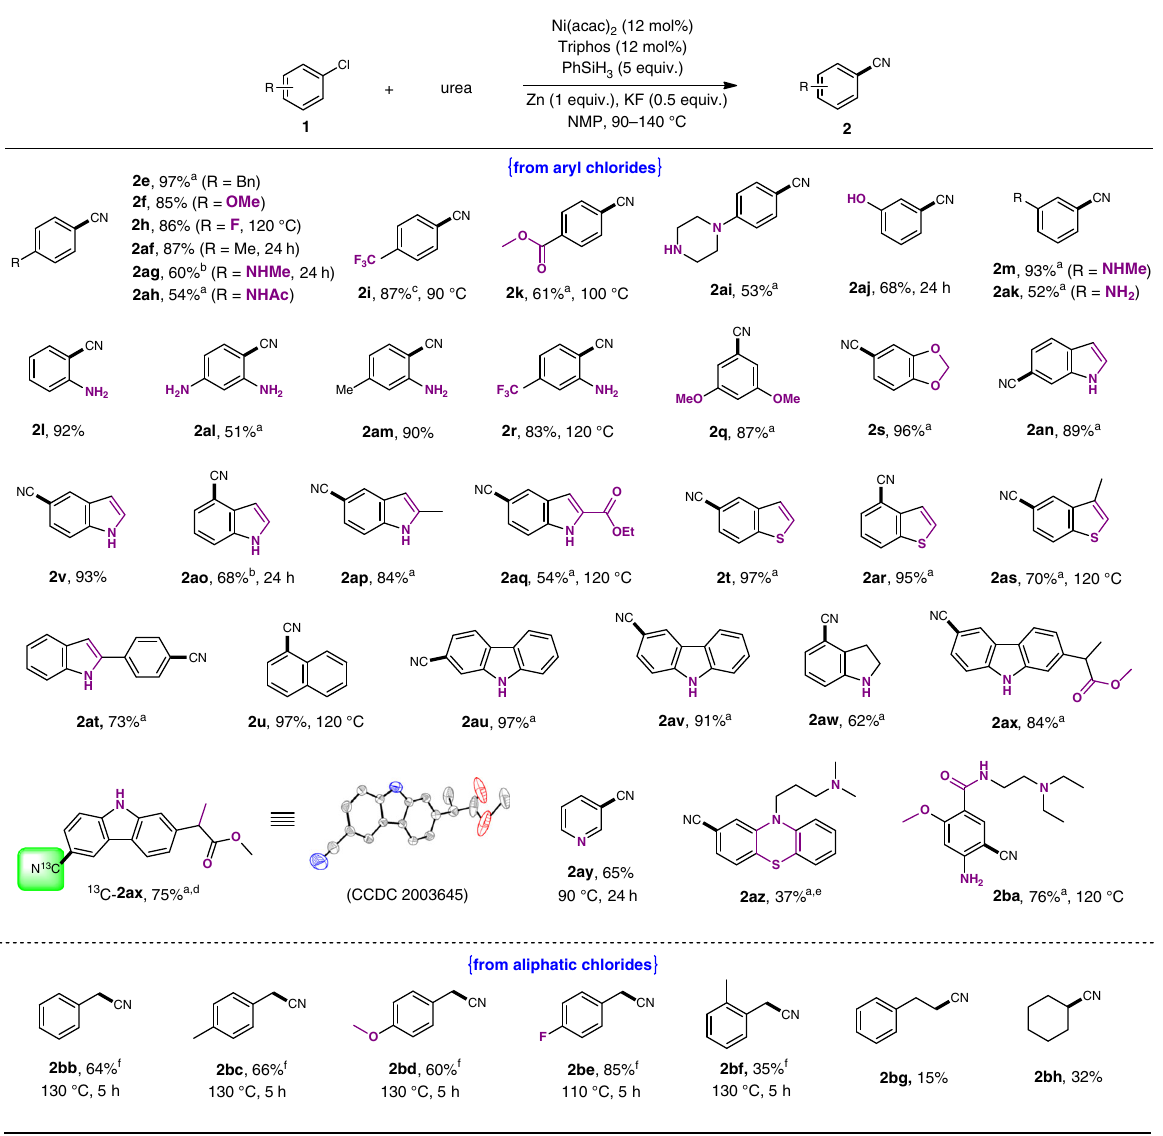
Fig. 5 Catalytic cyanation with other related CN sources. Reaction conditions: 0.3 mmol scale; GC yields. a 2 equiv. of PhSiH